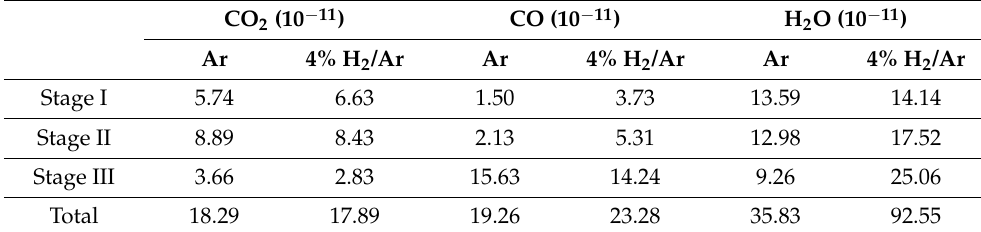
Figure 1. TPR spectra of the AC heated at 1 °C/min under different atmospheres. Table 1. Peak area values of the TPR